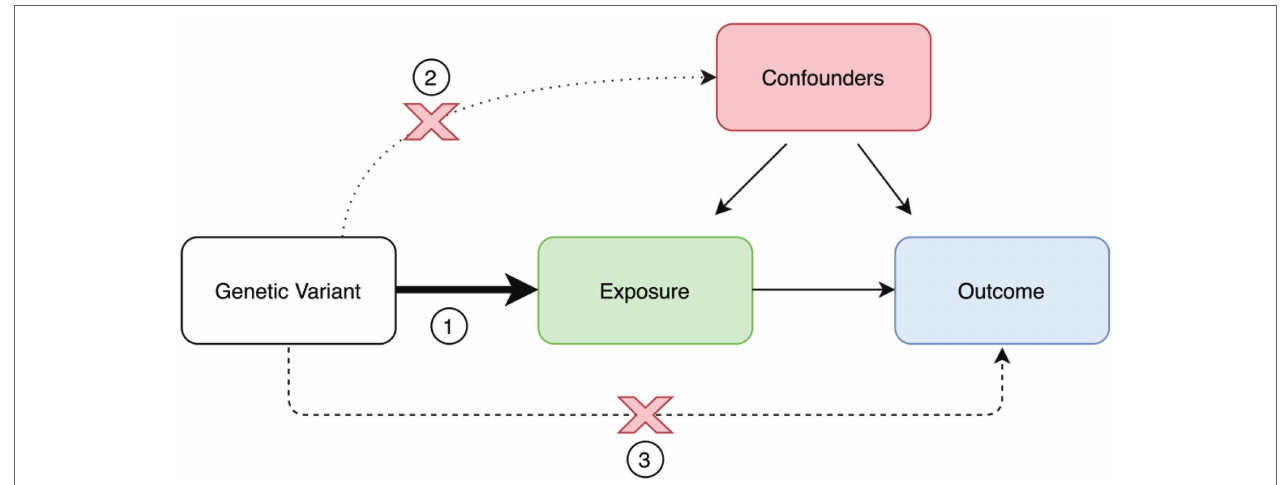
FIGURE 2 | Mendelian randomization paradigm and assumptions. Mendelian randomization assumptions: (1) valid instrument, (2) no association with confounders, and (3) no horizontal